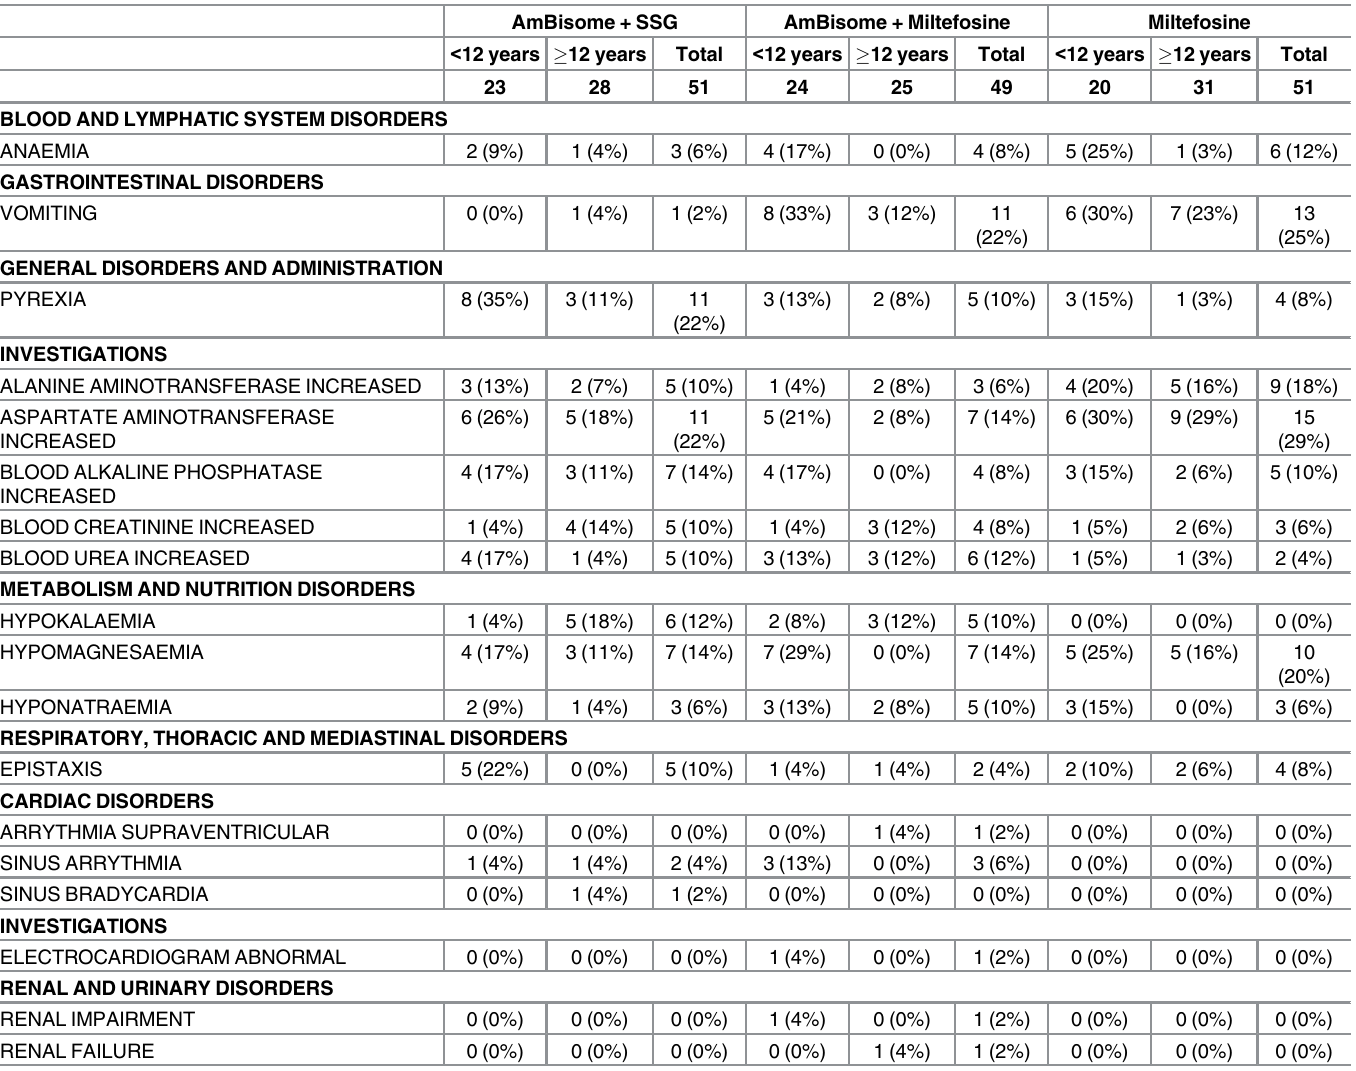
Table 8. Incidence of adverse drug reactions.